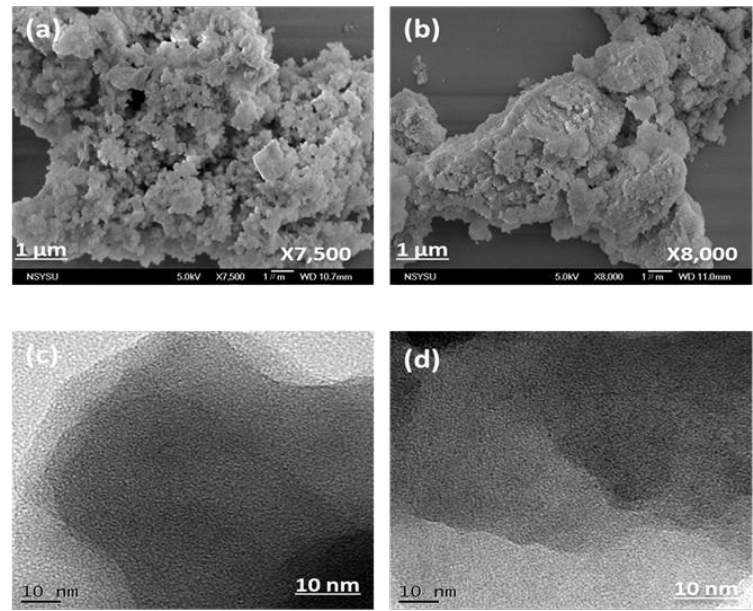
Figure 5. SEM and TEM images of ( a , c ) OVS-P-TPA HPP and ( b , d ) OVS-P-F HPP.